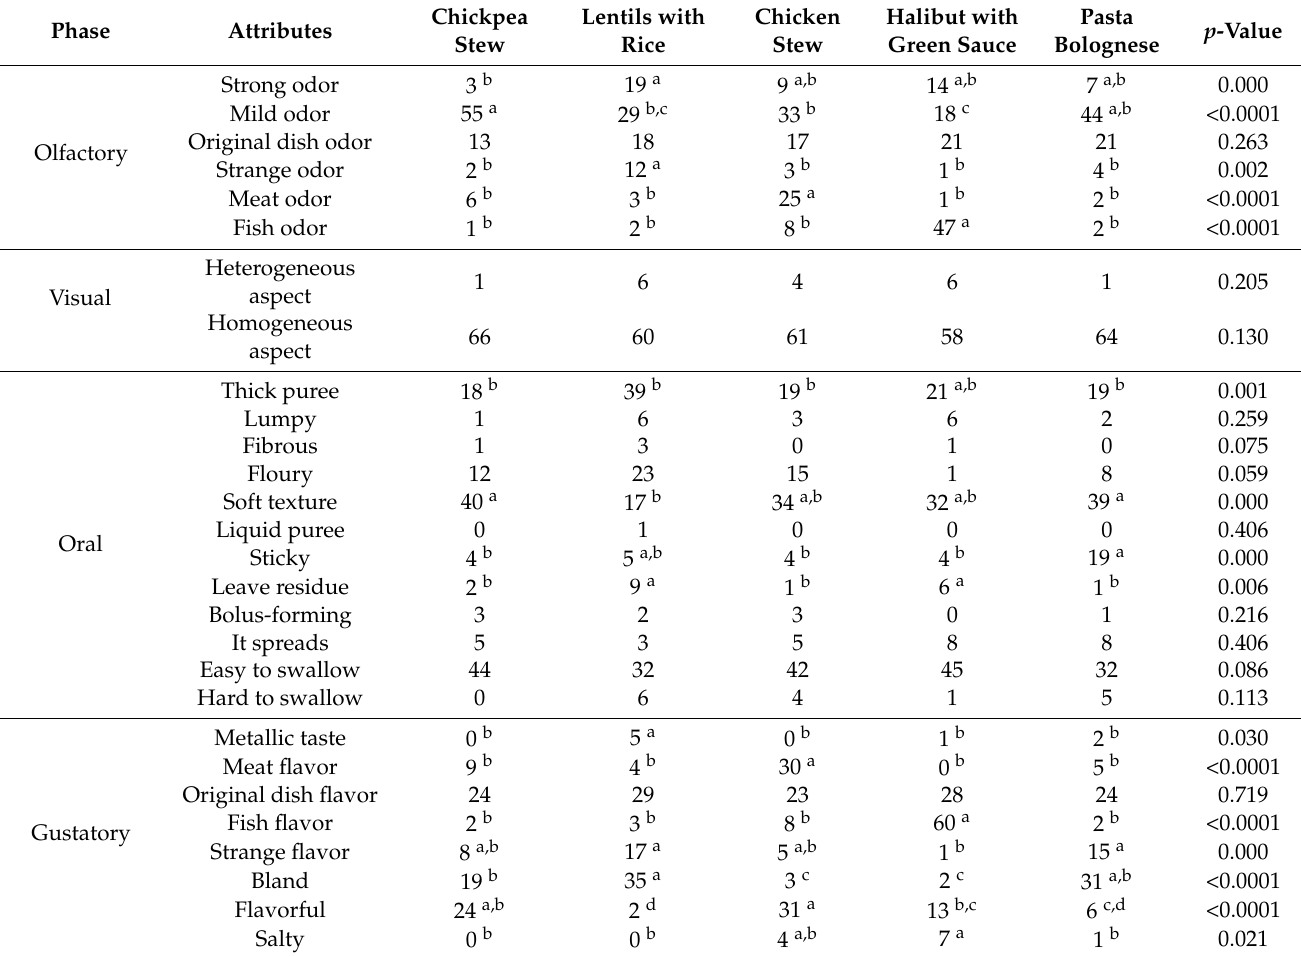
Table 3. Citation frequency of attributes associated with CP dysphagia adapted dishes in the CATA method.